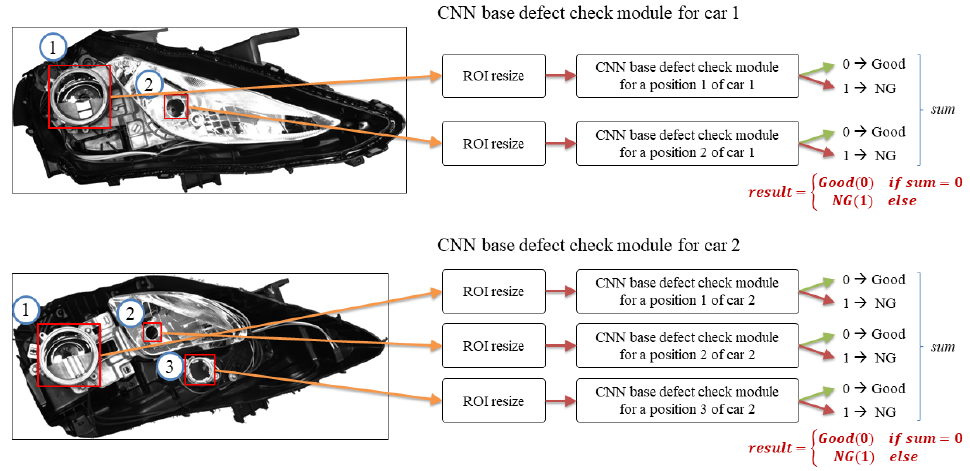
Figure 11. CNN-based defects check module structure.